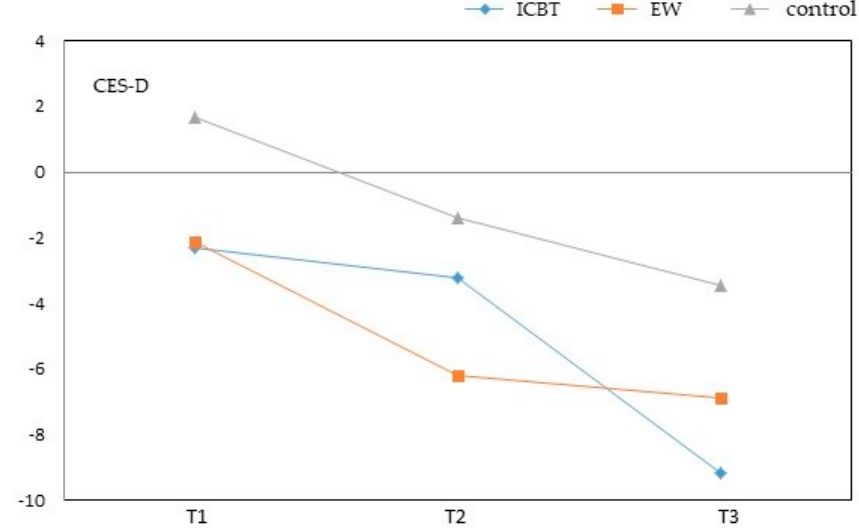
Figure 3. Adjustment mean change of CES-D over time. Adjustment mean was estimated using the ANCOVA model in Table 2. T1 = assessment at 2 weeks, T2 = assessment at 6 weeks and end of practicum, and T3 = assessment at 18 weeks.